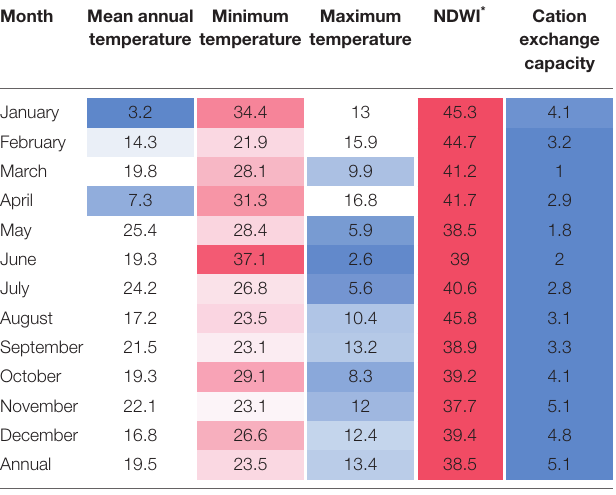
TABLE 1 | Variable importance for the annual and monthly ecological niche